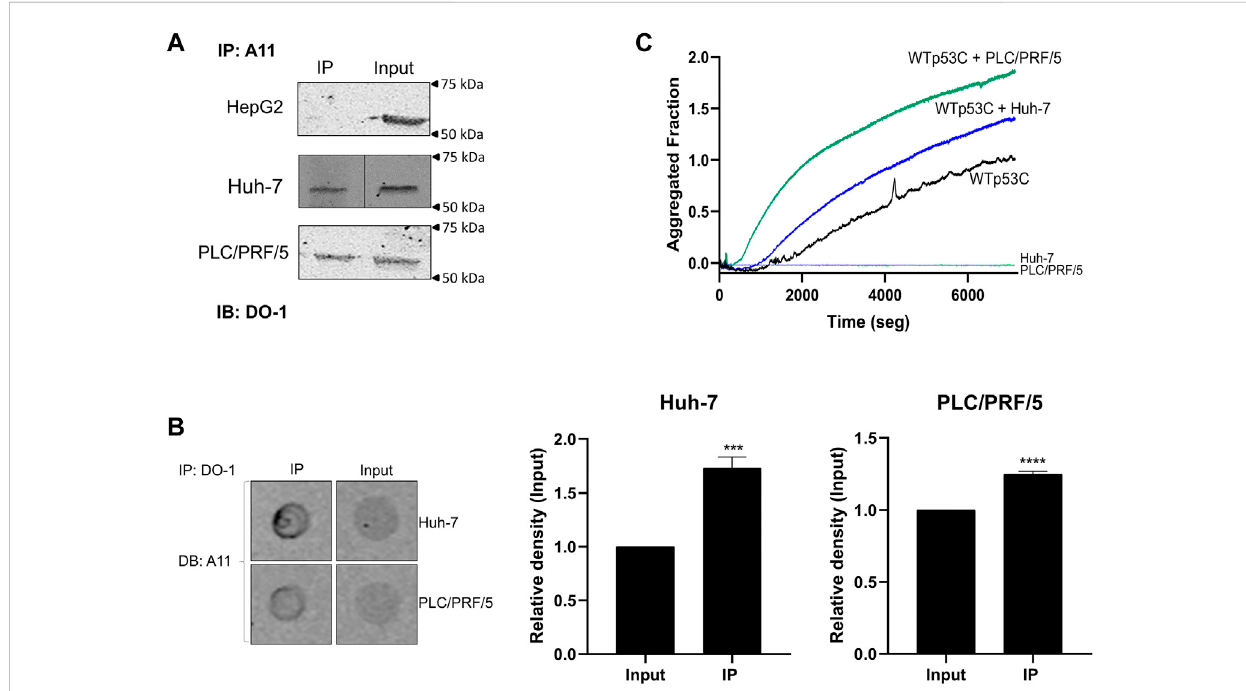
FIGURE 4 Amyloid-state and prion-like effect of mutant p53 HCC cell lines. (A) IP with A11, followed by immunoblotting (IB) with DO-1. (B) IP of amyloid oligomerswithp53withDO-1,followedbydot-blot(DB)assaywithA11.Thedifferencewasstatisticallysigni fi cantinIP.DBquanti fi cation(**** p < 0.0001, n =3).Input:celllysate. (C) WTp53Caggregationalone(blackline)orseededbymutantp53HCCcelllinelysates:PLC/PRF/5(greenline)andHuh-7(blue line).Thelightgreenlinecorrespondstothecelllysatealoneusedastheseed.Lysates(3 μ g/mL)wereusedtoinduceWTp53C(5 µM)aggregationin a solution containing 50 mM Tris (pH 7.2), 150 mM NaCl, 5 mM DTT, and 5% glycerol, followed by ThT (25 µM) fl uorescence (440 nm excitation and 482 nmemission)at37 ° C.Aggregated fraction=(Fobs-FI)/(FF-FI),whereFistheThT fl uorescenceemission,Fobsistheobserved fl uorescenceemission, FI is the initial fl uorescence, and FF is the fi nal fl uorescence. Each of the images shows an experiment representative of three independent